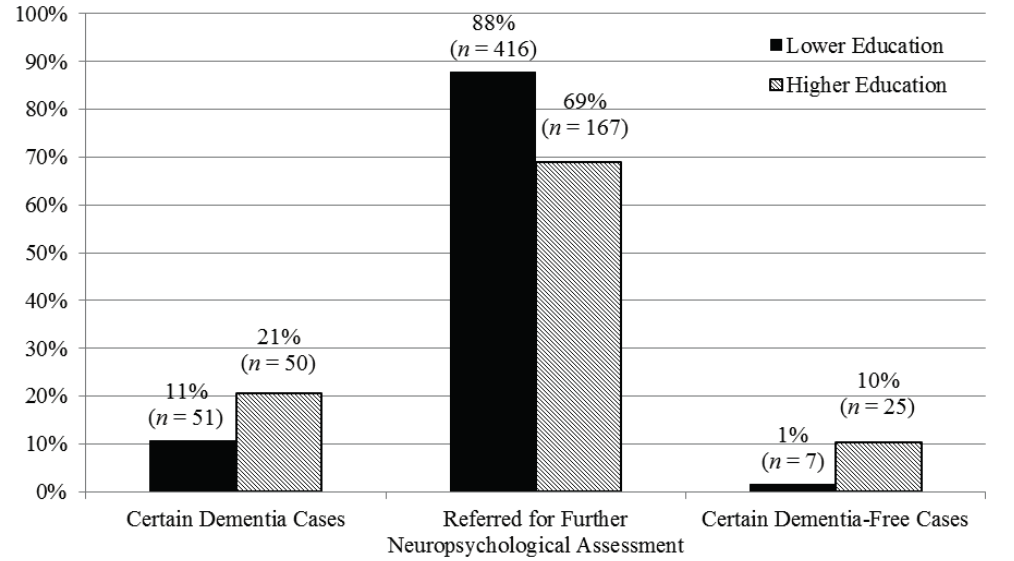
Figure 1. No. (%) of certain dementia cases, cases requiring further neuropsychological assessment, and certain dementia-free cases in lower and higher education